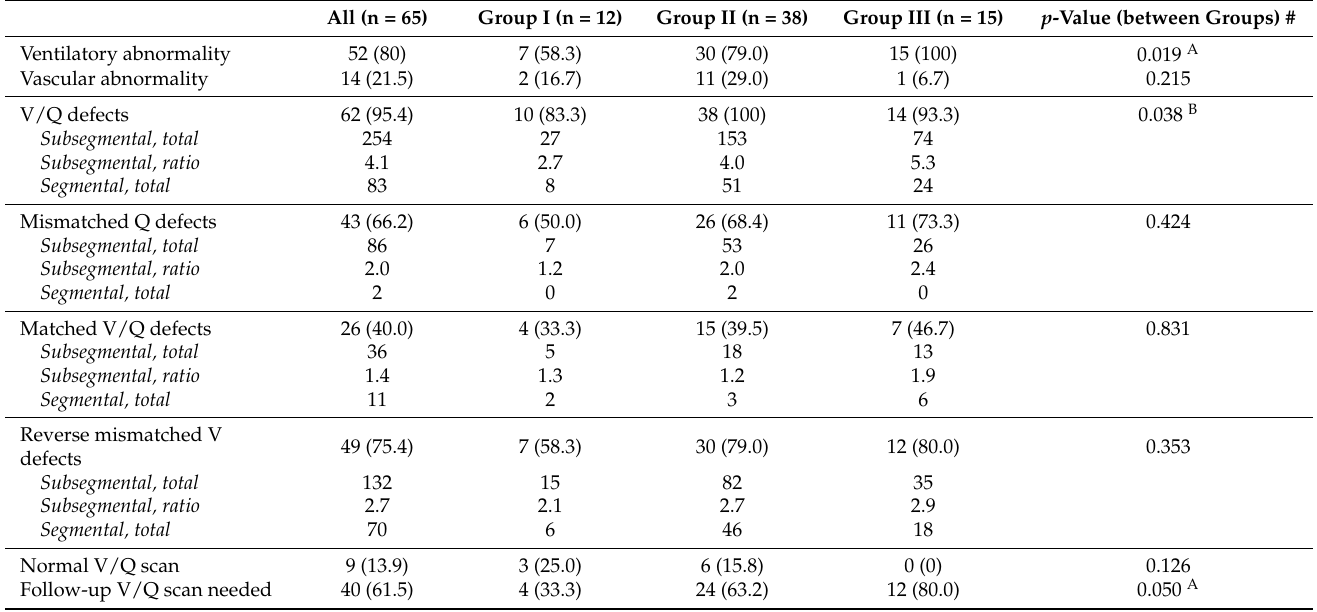
Table 4. VQ scintigraphy findings in patients 4 months after COVID-19 (n = 65) and differences between patients who were not hospitalised, hospitalised without ICU and with ICU treatment.